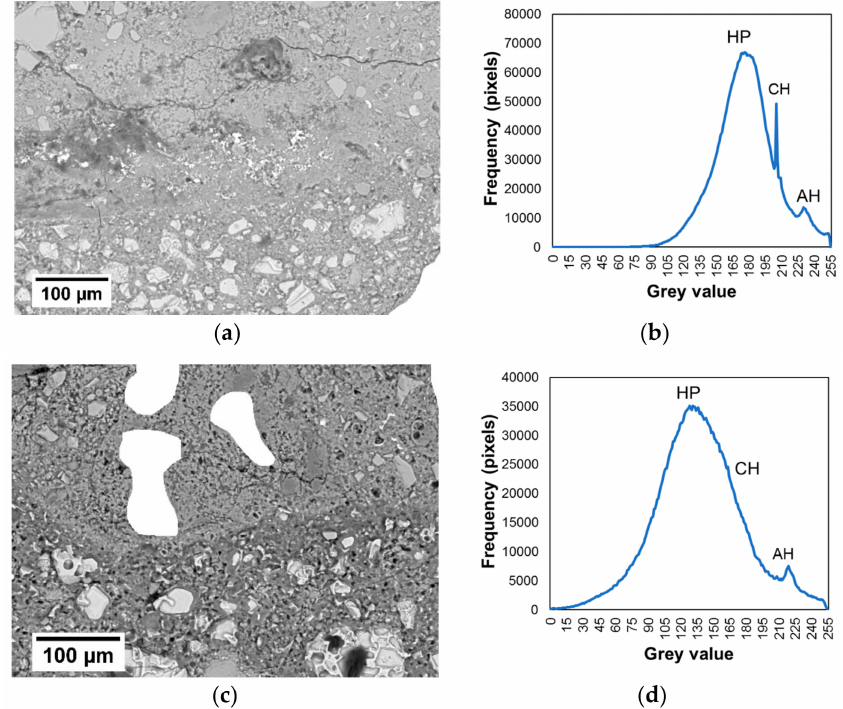
Figure 11. Exemplary backscattered electron (BSE) images of the samples cut from the interphase zone of the cement mortar used to make the overlay with the concrete substrate ( a , c ), which were made using a scanning electron microscope (SEM). Gray scale histograms ( b , d ). Figures ( a , b ) refer to the reference mortar without Al 2 O 3 nanopowder and ( c , d ) refer to the mortar modified with 0.5% of Al 2 O 3